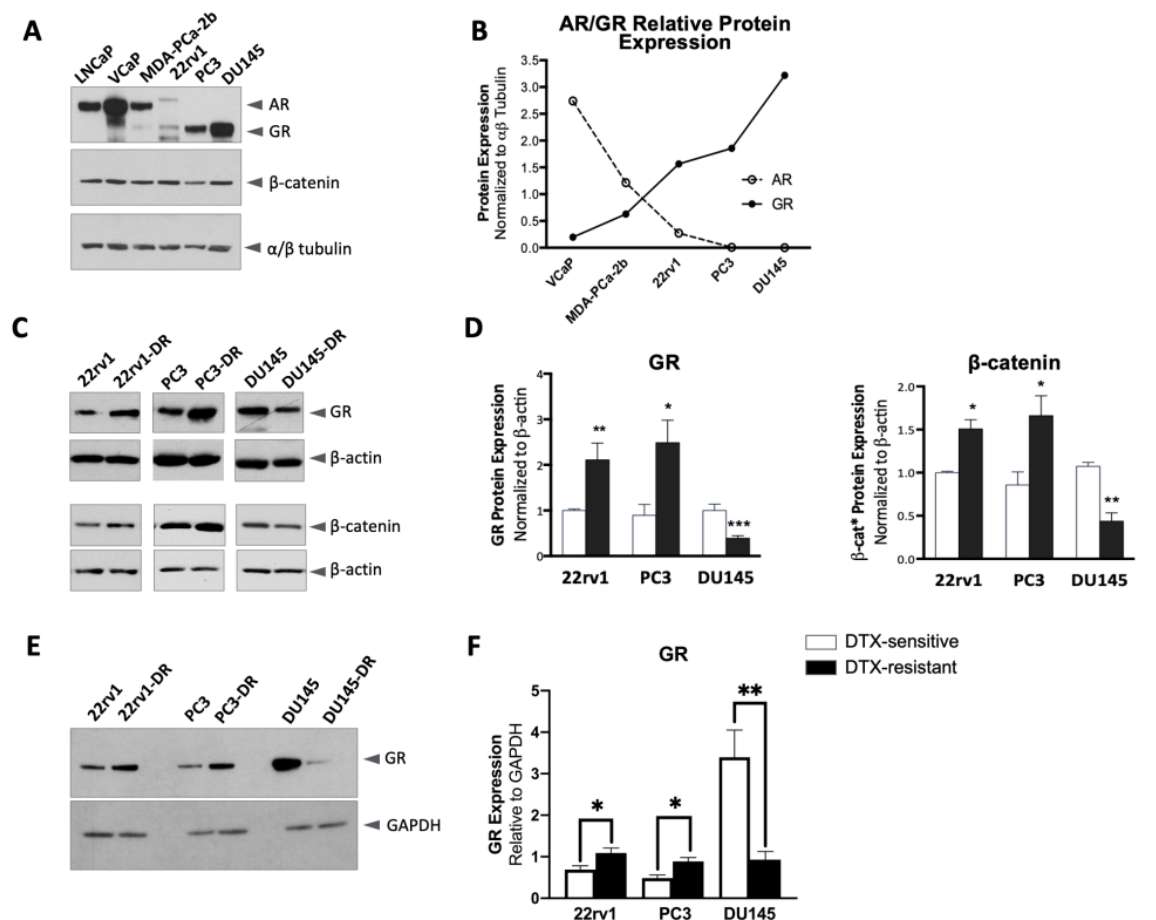
Figure 1. GR and β -catenin are differentially expressed in DTX-resistant PCa cells. ( A ) Total AR and GR expression, detected with specific, non-cross-reactive antibodies in immunoblots, are inversely related, while total β -catenin expression is relatively constant across a diverse panel of PCa cell lines grown under standard cell culture media supplemented with FBS. ( B ) Quantification of total AR and GR expression in selected cell lines shown in panel A. ( C ) Altered total GR and β -catenin protein expression detected by immunoblotting in parental, DTX-sensitive PCa cell lines (22rv1, PC3, and DU145) and their sublines selected for resistance to DTX (DR). The DR cell lines were generated by continuous exposure to incrementally increasing concentrations of DTX (0.1 nM to 10 nM) until stable (>95%) viability was achieved at 10 nM DTX, a pharmacologicallyrelevant concentration that was used for maintaining the cells in culture. ( D ) Quantification of GR and β -catenin from immunoblots normalized to β -actin. Data include 5 independent sample sets and are represented as mean ± SEM. ( E ) Total GR expression in the three pairs of cell lines (sensitive vs. DR) was detected in the same blots. ( F ) Quantification of GR from immunoblots relative to GAPDH. Data include at least 3 independent immunoblots and are represented as mean ± SEM (* p < 0.05, ** p < 0.01, *** p <